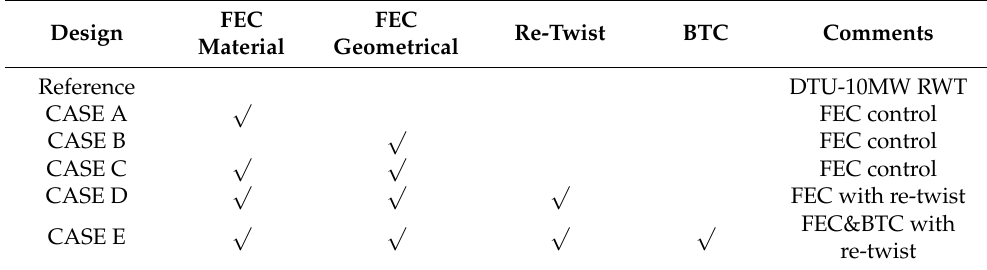
Table 1. DTU-10MW RWT passive control designs aimed at minimizing the LCoE